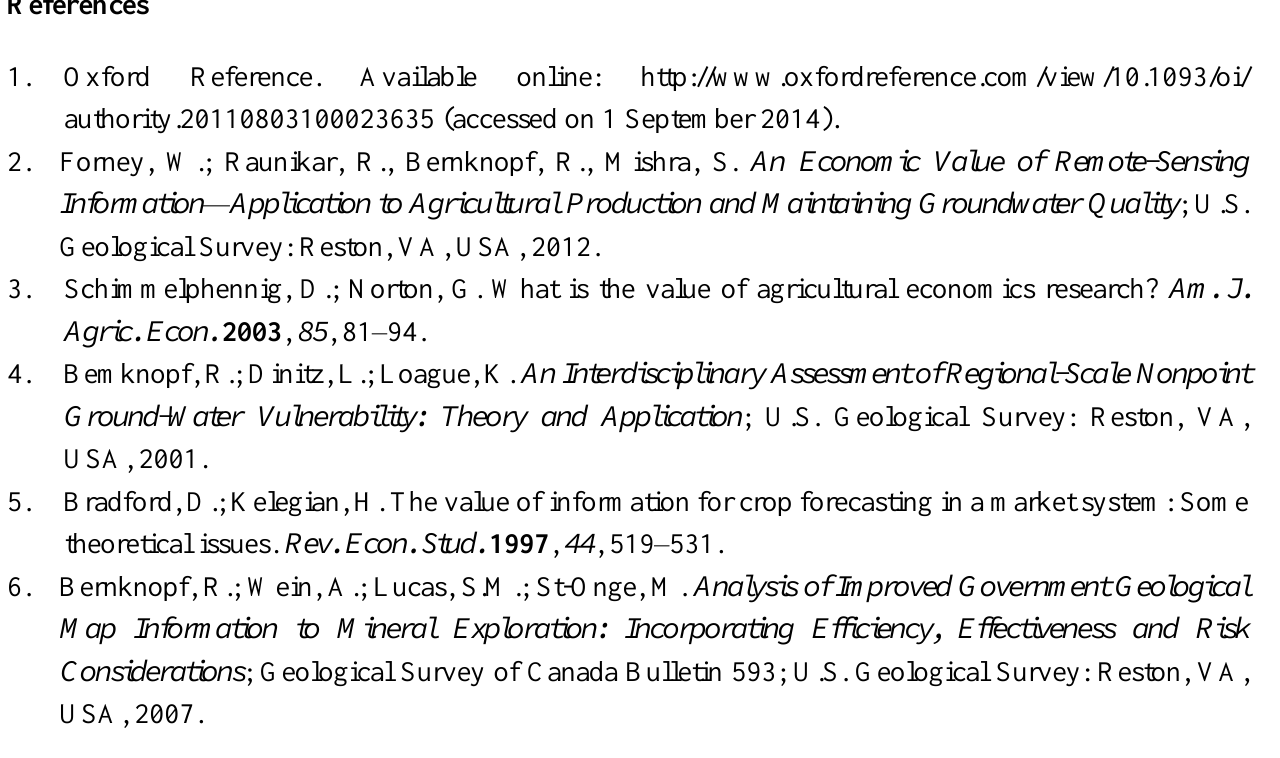
Figure A1. A production possibility curve for a technological innovation in applying geospatial data in regional natural hazard policy and